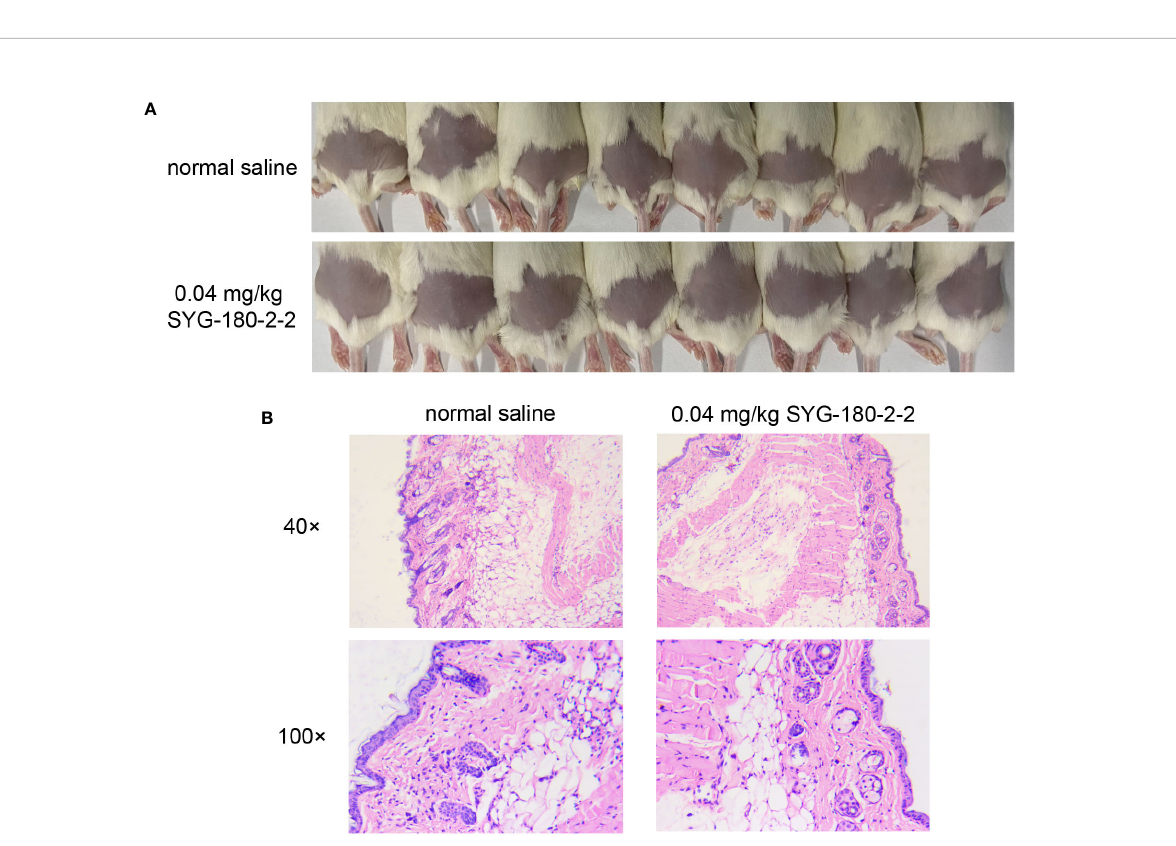
FIGURE 7 The safety evaluation of topical application SYG-180-2-2 in vivo . (A) Skin conditions of mice before and after SYG-180-2-2 treatment on day 4. (B) Pathological sections of representative mice between the SYG-180-2-2 group and the saline